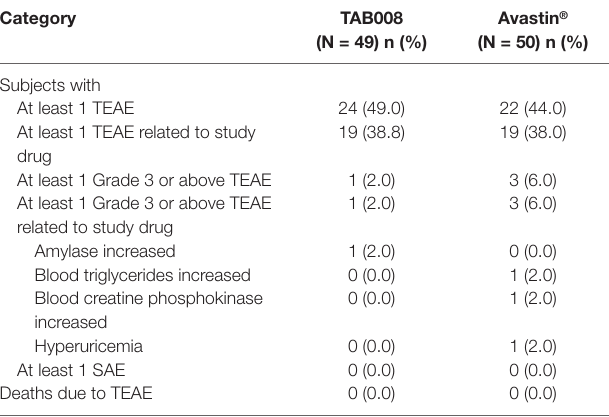
TABLE 4 | Summary of most frequent (>2%) treatment-related treatment- emergent adverse events by system organ class and preferred term for each treatment group (safety analysis set).